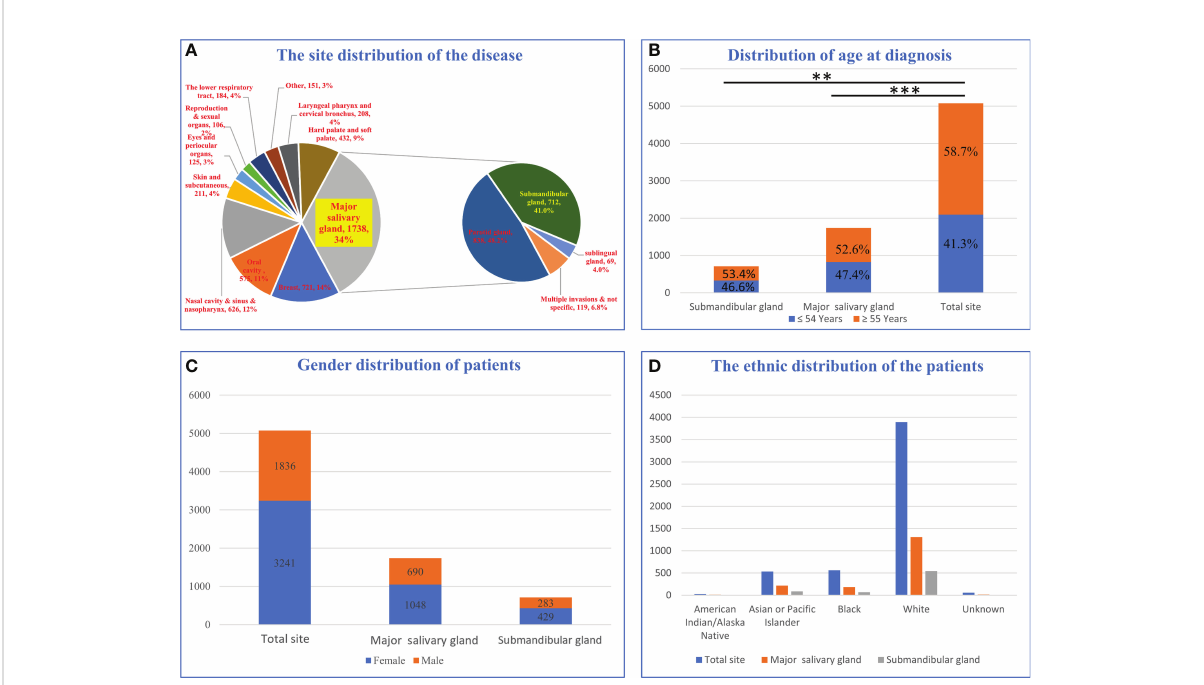
FIGURE 2 Epidemiological analysis of patients with submandibular gland ACC. (A) Distribution of disease sites in 5077 patients. (B) Age distribution of submandibular gland ACC compared with the major salivary glands and all parts of the body. (C) Sex distribution of patients with submandibular gland ACC compared with major salivary glands and body parts. (D) The racial distribution of submandibular gland ACC compared with major salivary glands and body parts (** P-value <0.01; *** P-value <0.001).